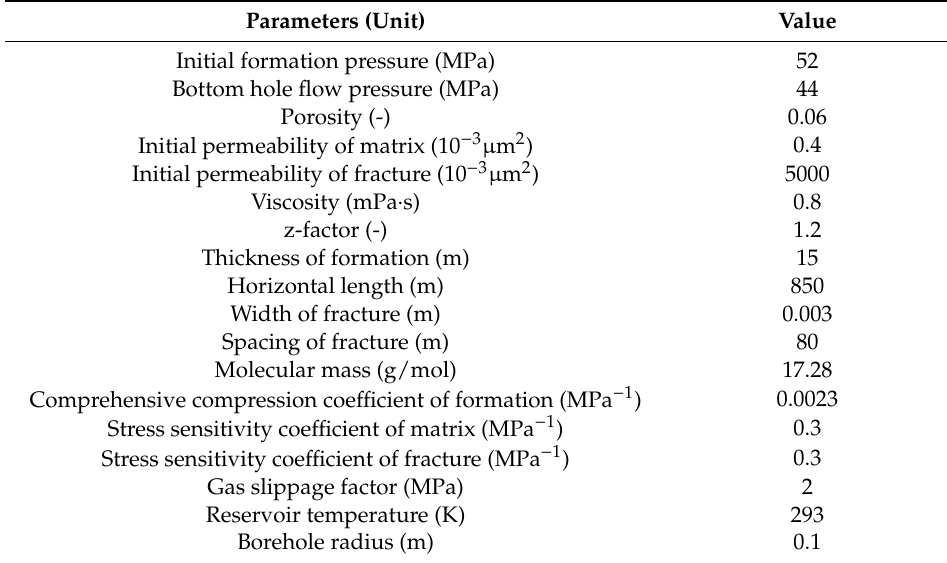
Table 1. Fundamental parameters of a gas field at Jilin Oilfield in